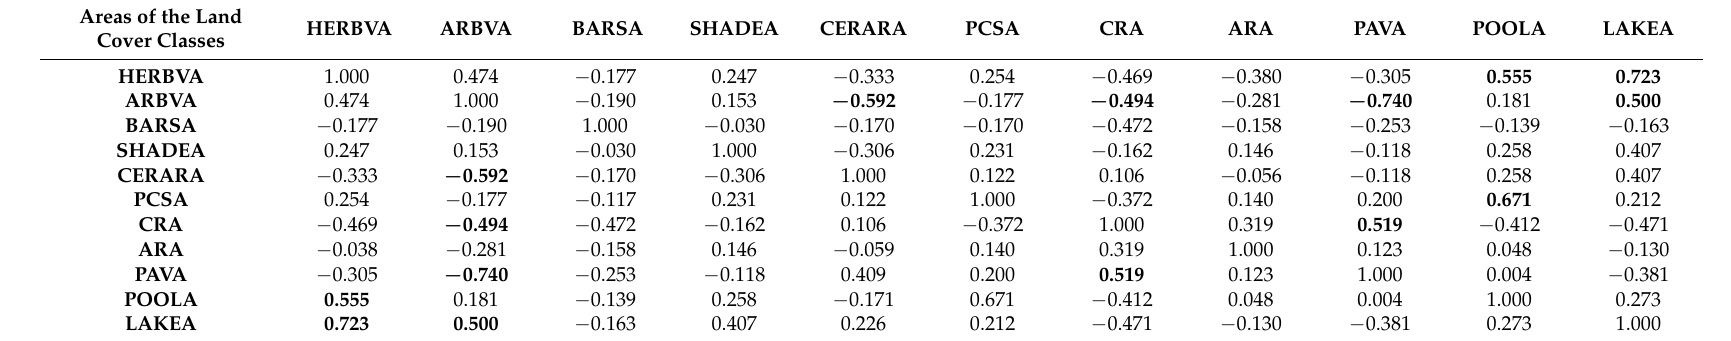
Table 4. Land cover class correlation